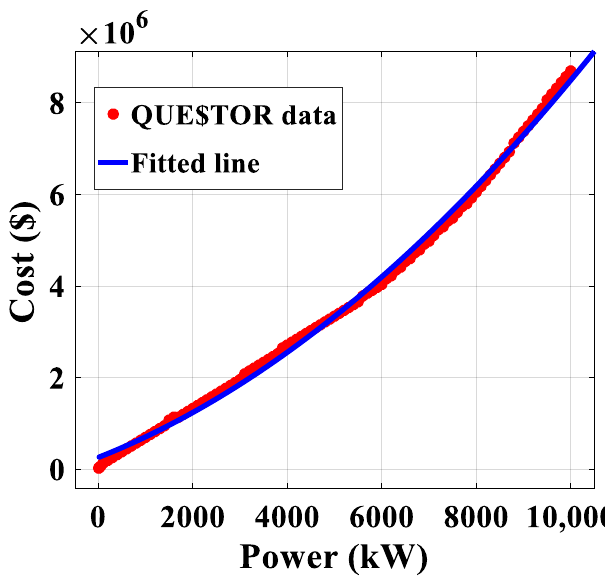
Energies 2021 , 14 , x FOR PEER REVIEW Figure 1. Fitting line for centrifugal compressor. Figure 1. Fitting line for centrifugal compressor.